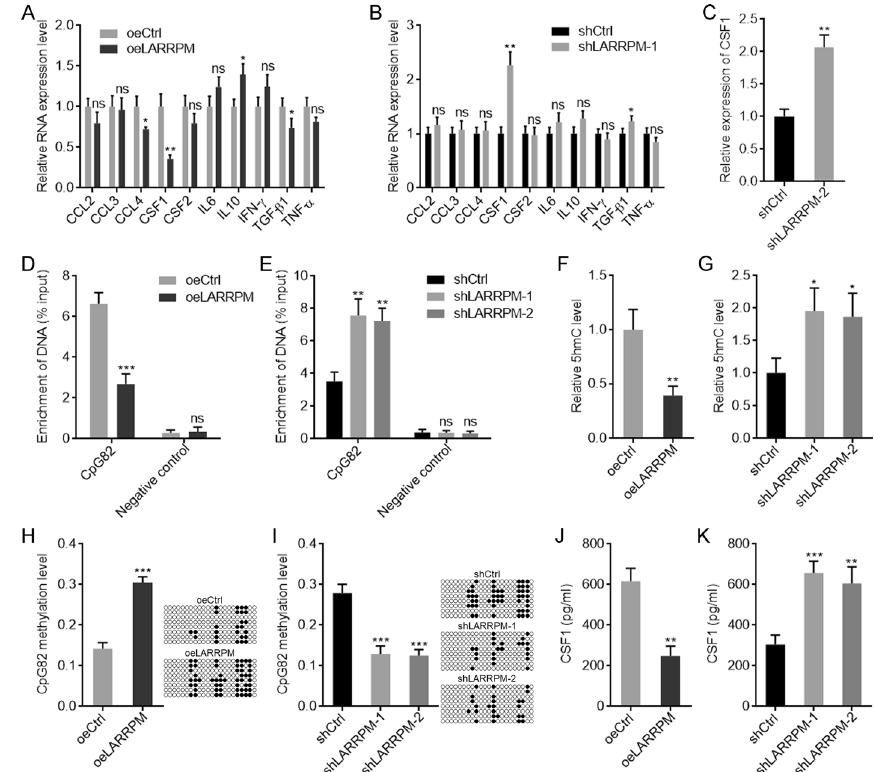
Fig. 7 LARRPM repressed CSF1 expression via inducing DNA methylation. a , b The expression of cytokines related to macrophage recruitment and polarization in A549 cells with LARRPM overexpression ( a ) and HCC827 cells with LARRPM depletion ( b ) was detected by qRT‑PCR. c The expression of CSF1 in another LARRPM stably depleted HCC827 clone was detected by qRT‑PCR. d , e ChIP assays followed by qPCR were performed in A549 cells with LARRPM overexpression ( d ) and HCC827 cells with LARRPM depletion ( e ) to detect the DNAs ( LINC00240 promoter) bound by TET1. f , g 5hmC levels of the CpG island CpG82 from A549 cells with LARRPM overexpression ( f ) and HCC827 cells with LARRPM depletion ( g ) were measured using the EpiMark 5‑hmC Analysis Kit. h , i DNA methylation levels of CpG82 from A549 cells with LARRPM overexpression ( h ) and HCC827 cells with LARRPM depletion ( i ) were measured using bisulfate DNA sequencing. j , k CSF1 secretion from A549 cells with LARRPM overexpression ( j ) and HCC827 cells with LARRPM depletion ( k ) was measured by enzyme‑linked immunosorbent assay (ELISA). Results are shown as the mean SD based on three independent experiments. Asterisks indicate a significant different at * P < 0.05, ± ** P < 0.01, *** P < 0.001, ns, not significant, by Student’s t ‑test ( a – d , f , h , j ) or one‑way ANOVA followed by Dunnett’s multiple comparisons test ( e , g , i , k ). CCL2, -3, -4 CC chemokine family, CSF1, CSF2